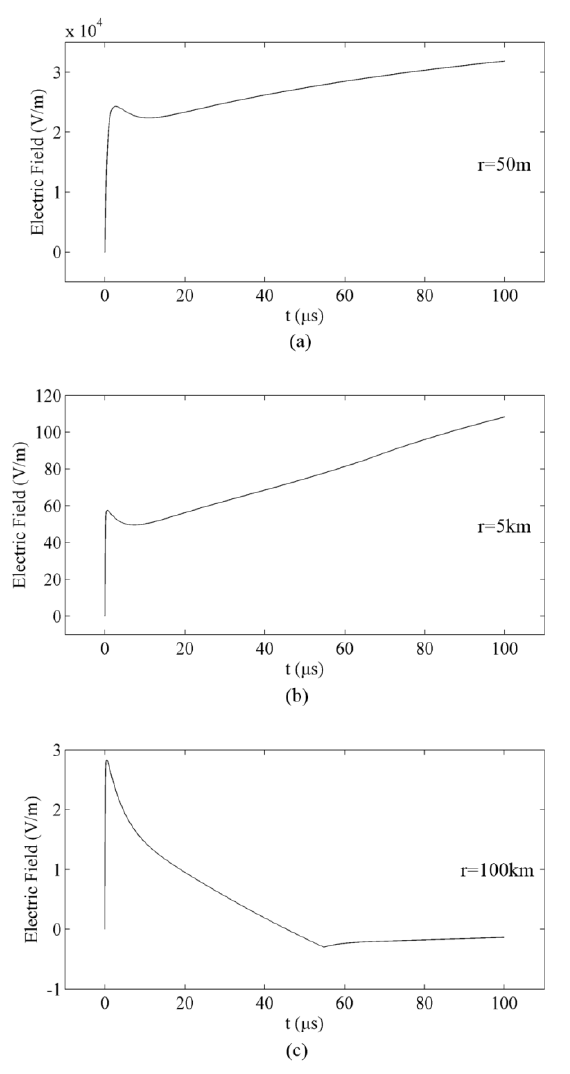
Figure 2. Vertical electric field used for the lightning channel base current computation at: ( a ) 50 m, ( b ) 5 km, ( c ) 100 km distance from the lightning channel.